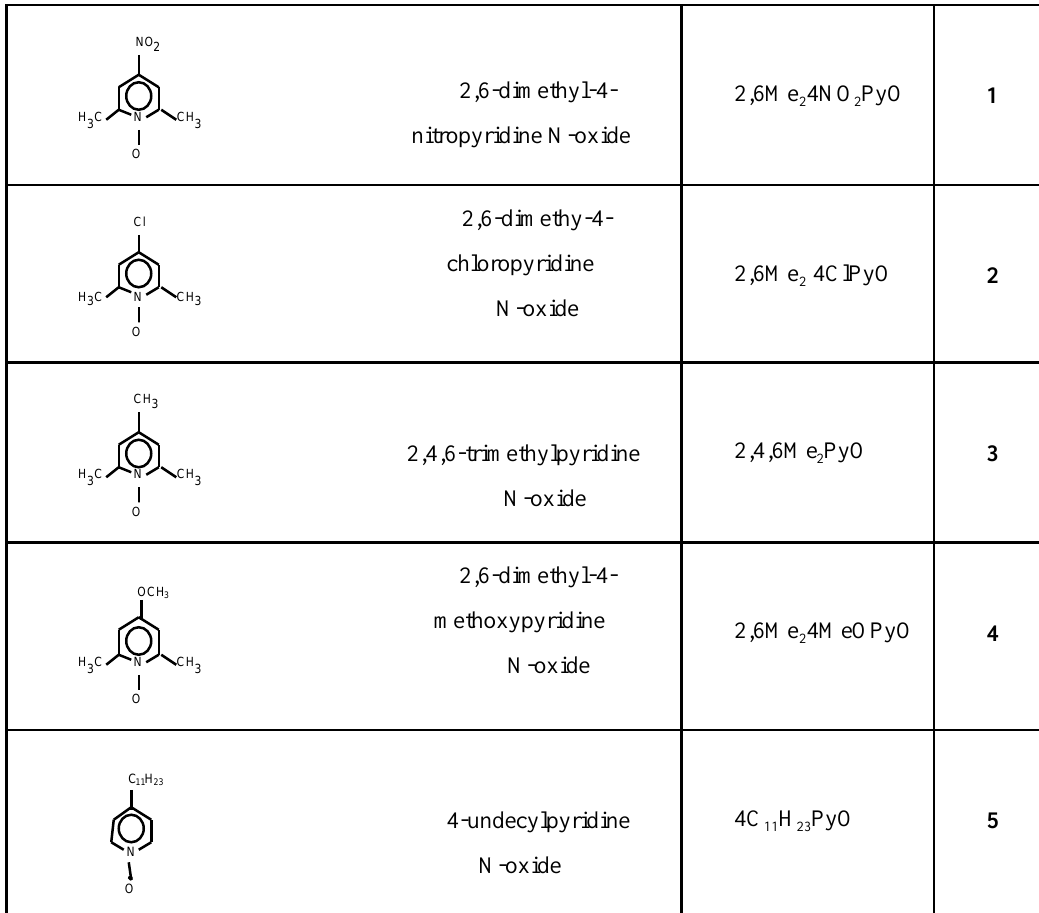
Table 1. Structures, full names, abbreviations and numbers used in text for N-oxides